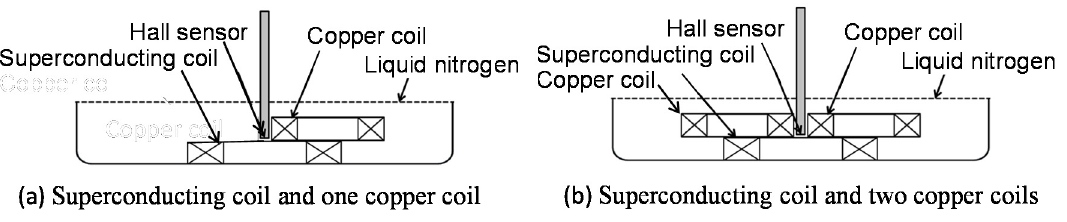
Figure 7. Experimental setup for mutual interaction between superconducting coil and copper